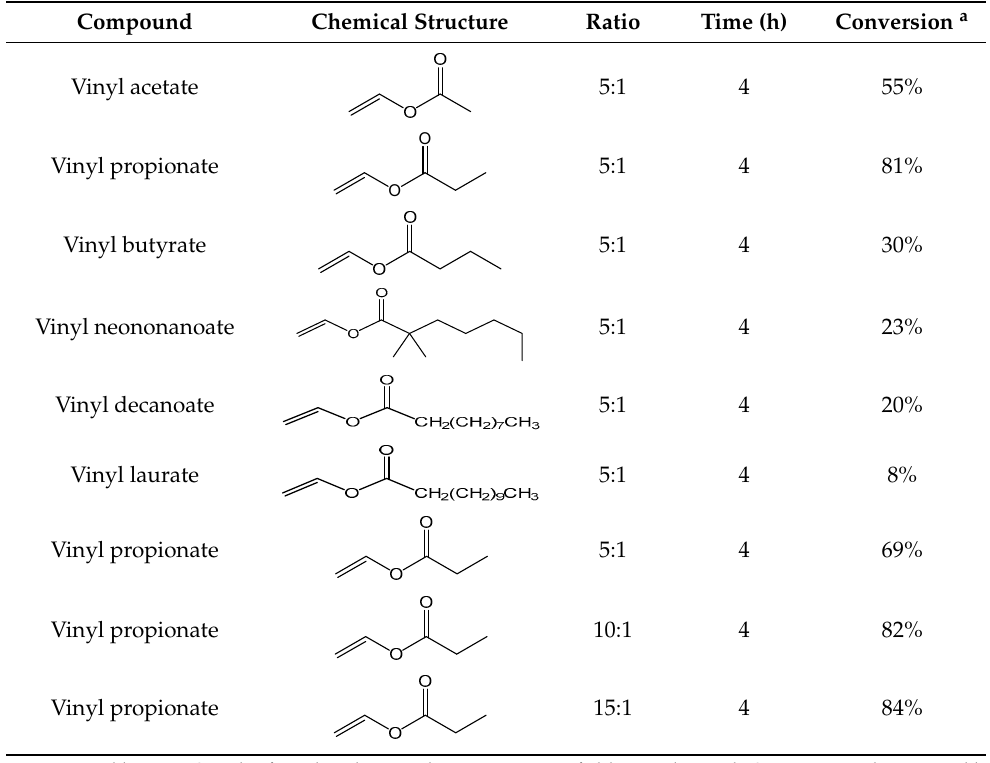
Table 2. The acyl donors’ effect on the yield of chloramphenicol. Reaction conditions: enzyme loading